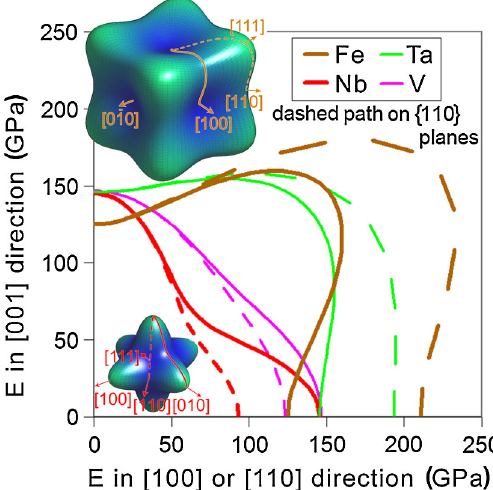
FIG. 5. (Color) The elastic anisotropy of BCC metals is plotted on f 100 g and f 110 g planes showing maximum and minimum values of Young’s (tensile) modulus, E (the vector from the origin to the curve gives the direction and magnitude). The maximum stiffness in Fe is along h 111 i , which is the most compliant in Nb. Nb is the most compliant of BCC metals